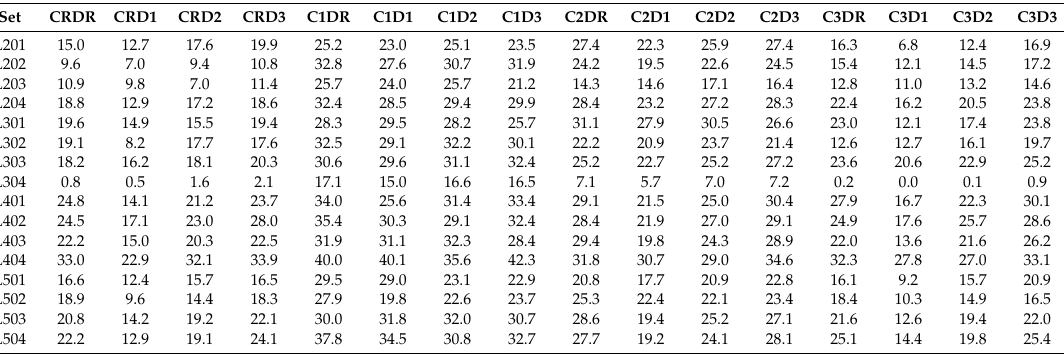
Table 7. Mean HV values of 16